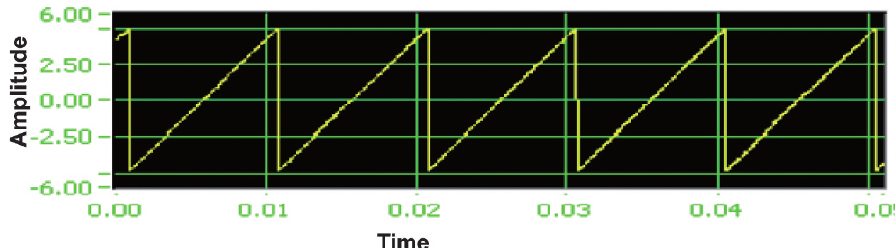
Figure 4 - A diagram showing the output pattern obtained from a 100-Hz sawtooth wave.